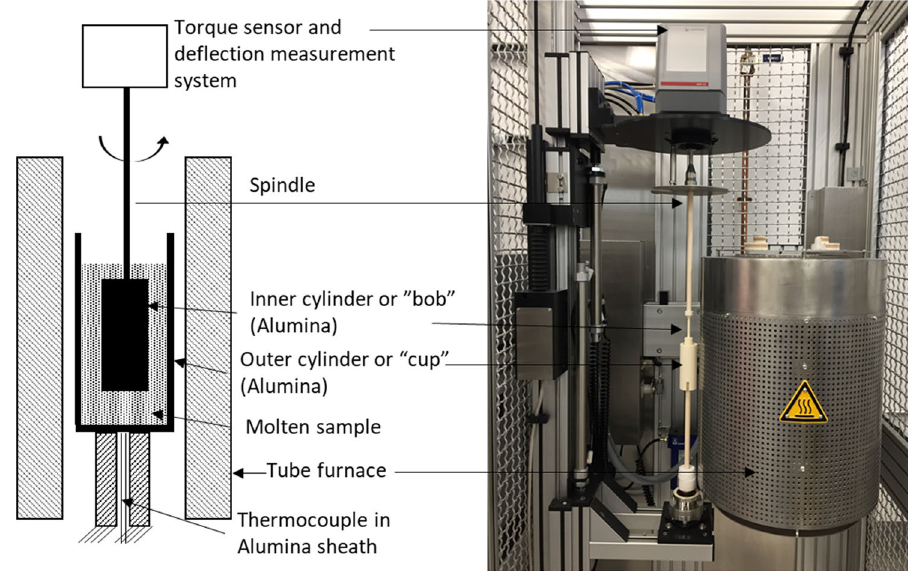
Fig. 1 Schematic of the concentric cylinder rheometer used in this